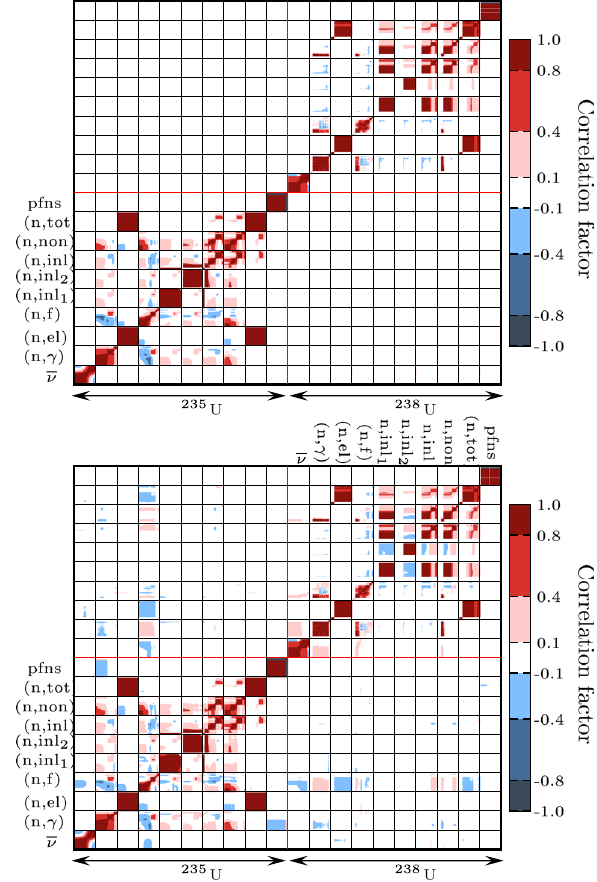
Fig. 4. Correlation sub-matrix between the n of 235 U and the fi ssion cross section of 235 U. The red cross indicates the average energy of the neutron causing fi ssion events (Tab.